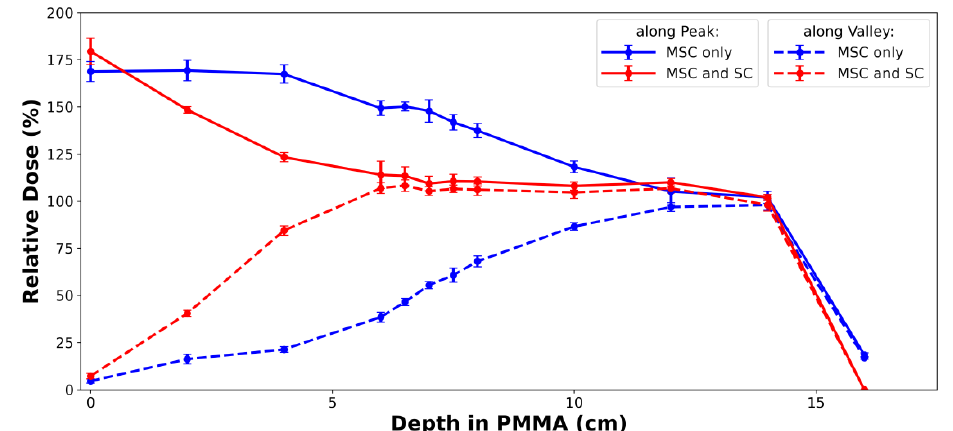
Figure 6. Comparison of depth dose profiles measured by EBT3 films (Figure 5D) for proton beams with 163.3 MeV nominal energy and 10 cm SOBP. The red-colored profiles show the effect of 2 mm thick lead scatterer. If the MSC is only used without the scatterer in pMBRT, a uniform dose cannot be delivered to the entire tumor volume. The measured doses were normalized by the most distal film dose, and there seemed to be weak quenching effect. The range of 163.3 MeV proton beam was about 16.2 cm in PMMA. SC: lead scatterer.